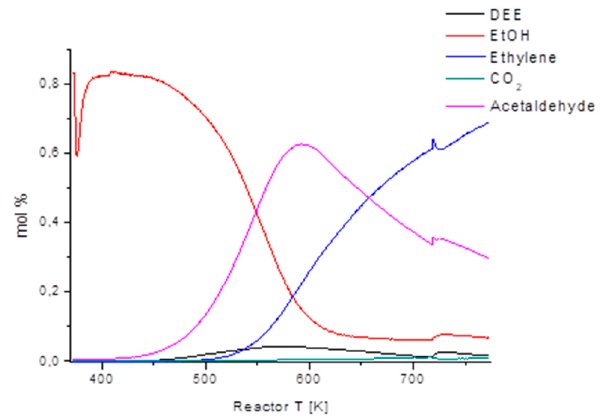
Figure 9. Ethanol TPSR in the oxidative dehydrogenation experiment (0.8% ethanol / 6% O 2 and N 2 balance, GHSV = 240,000 h − 1 ) over 7%Mo / Al 2 O 3 (2.5% SiO 2 ) home-made catalyst.